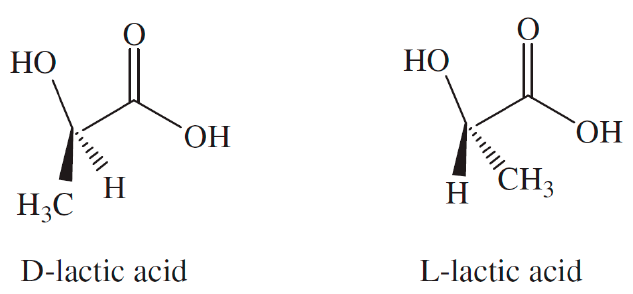
Figure 1. Enantiomers of lactic acid [55].